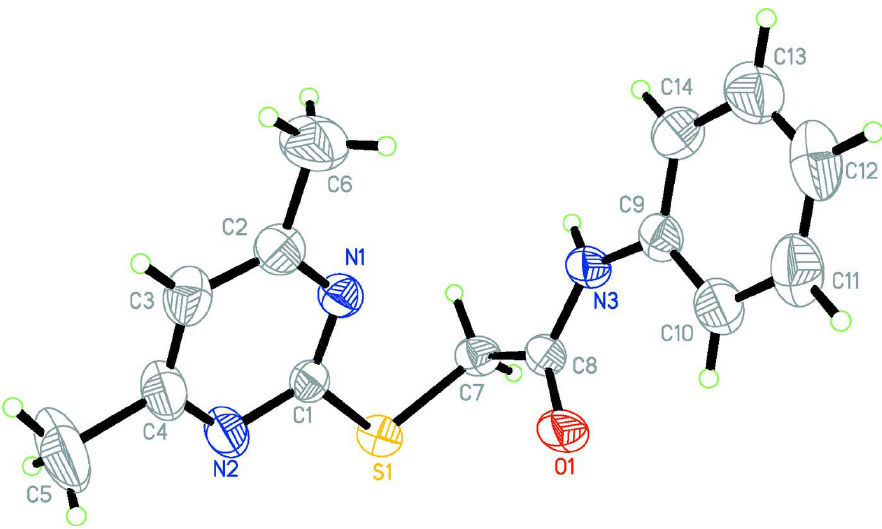
Figure 1 View of the molecule of (I) showing the atom-labelling scheme. Displacement ellipsoids are drawn at the 30% probability